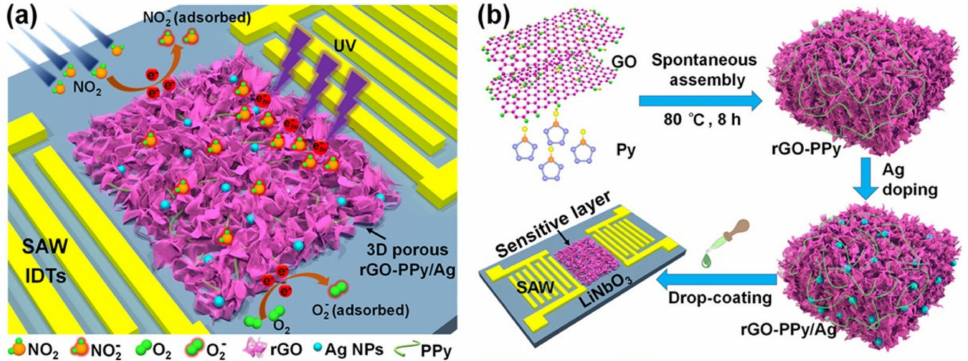
Figure 2. ( a ) Schematic illustration of the adsorption mechanism of NO 2 molecules on the proposed SAW sensitive layer. ( b ) Synthesis process of 3D porous architecture rGO − PPy/Ag composite. Reprinted with permission from [37]. Copyright 2021 American Chemical